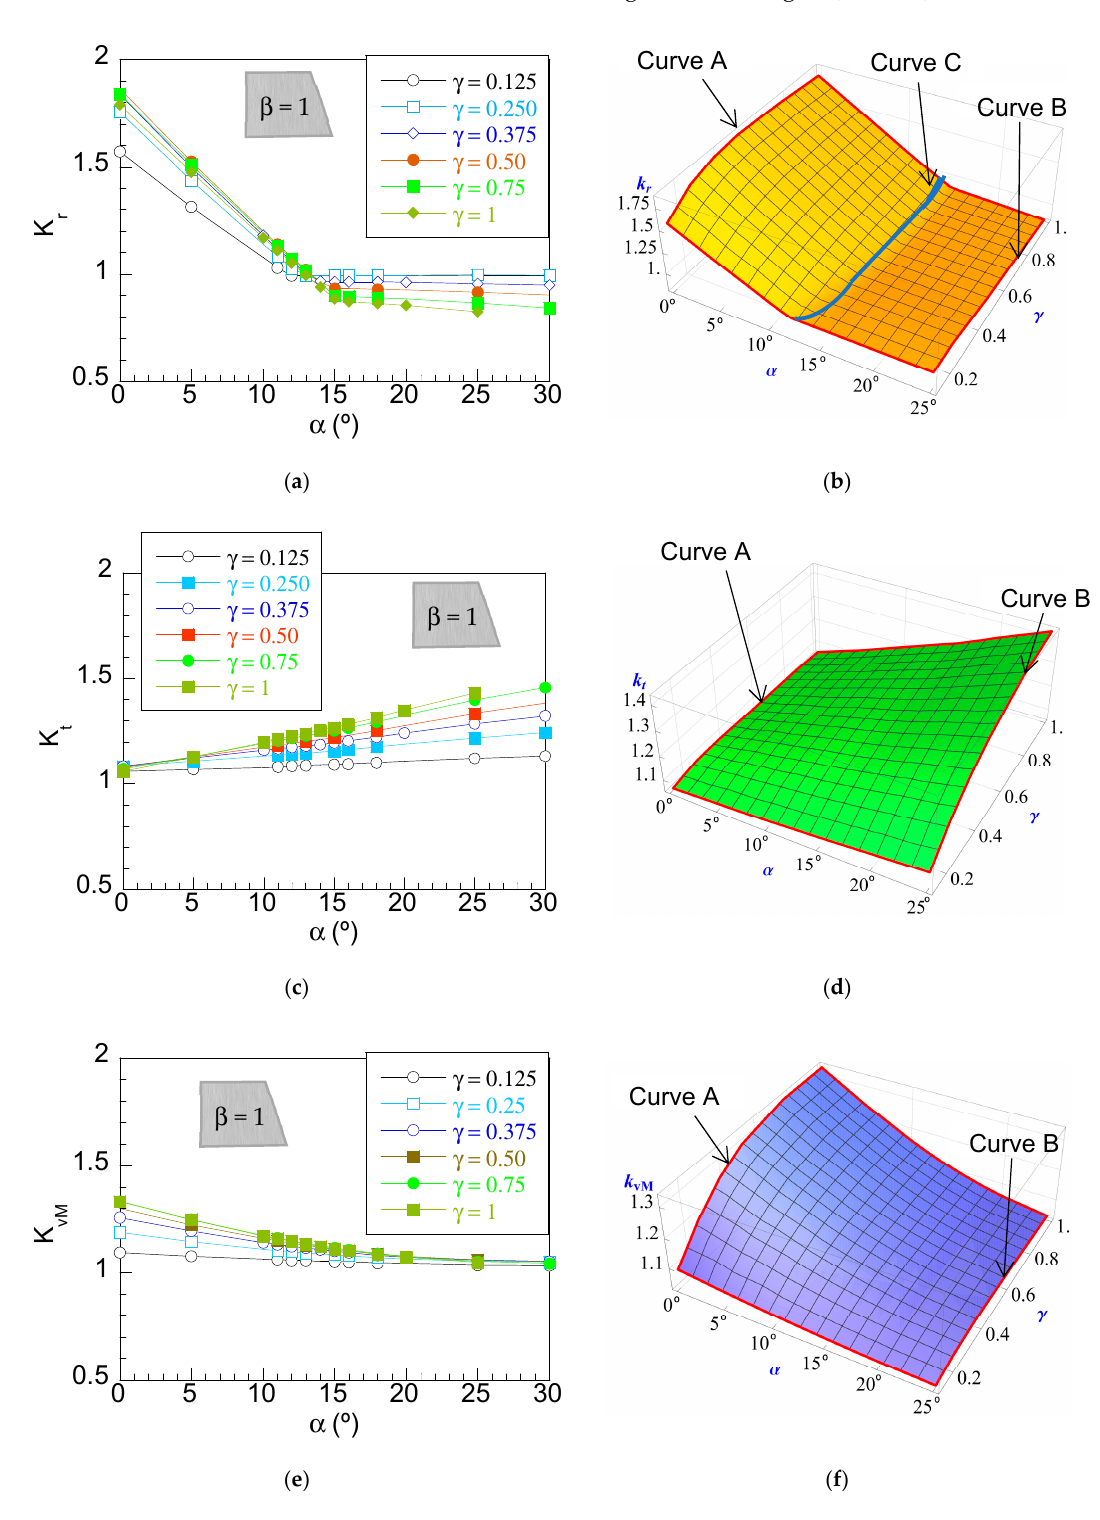
Figure 10. Stress concentration factors as a function of the chamfer angle, α , for different values of the hub edge γ . ( a ) radial stress, ( b ) 3D view, ( c ) tangential stress, ( d ) 3D view, ( e ) von Mises stress, ( f ) 3D view.